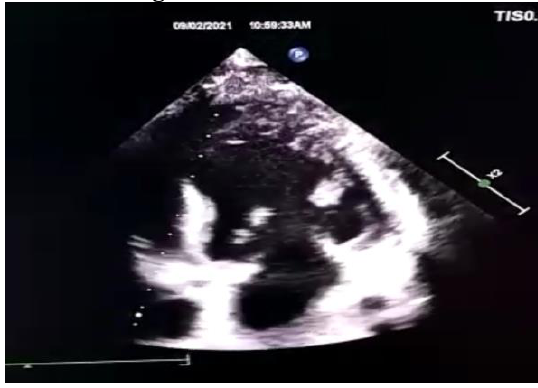
1: TTE revealed severe mitral insufficiency with rupture papillary